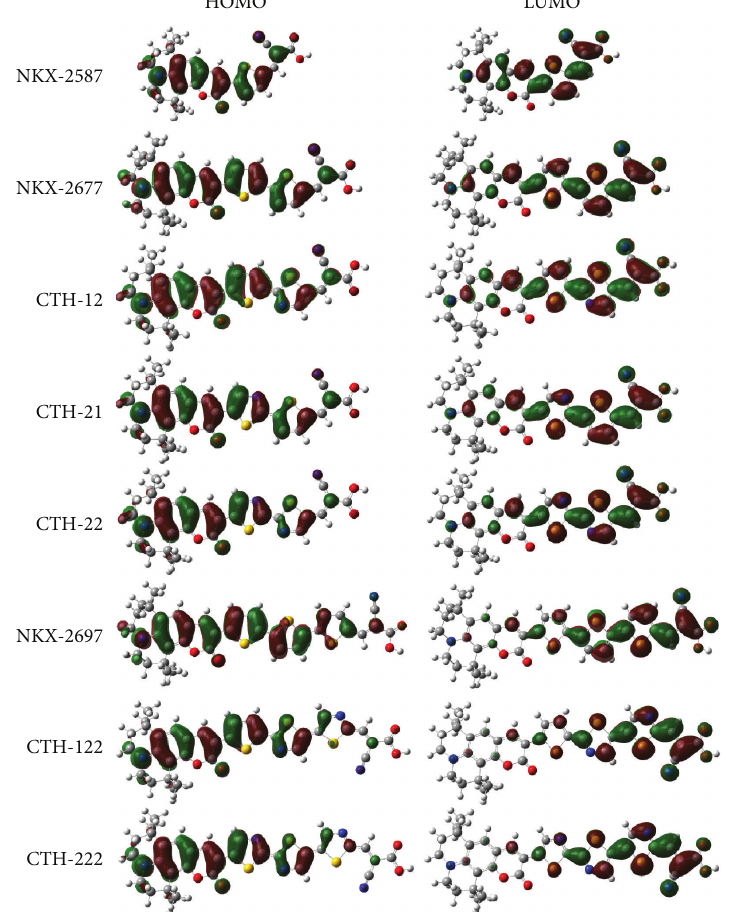
Figure 4: HOMO and LUMO molecular orbitals at M06/6-311G(d) level of